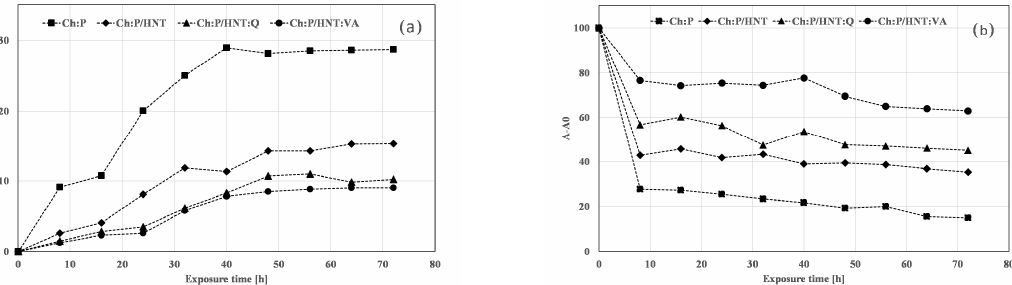
Figure 7. Variation of ( a ) >C=O and ( b ) NH bending for Ch:P and Ch:P/HNT without and with natural antioxidants. natural antioxidants.